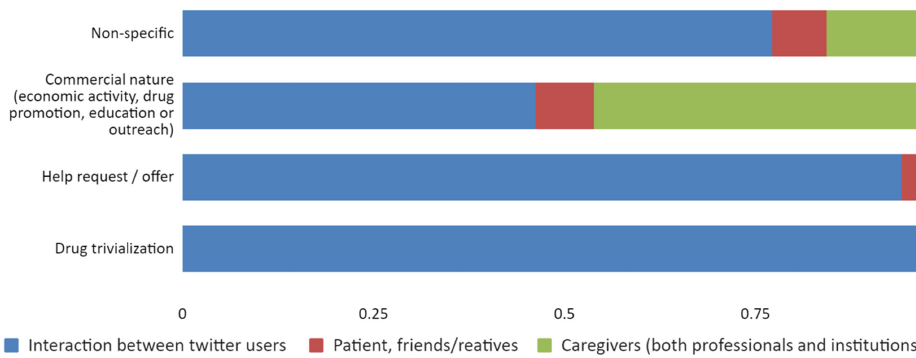
Figure 4. Proportion of type of user by non-medical content category.